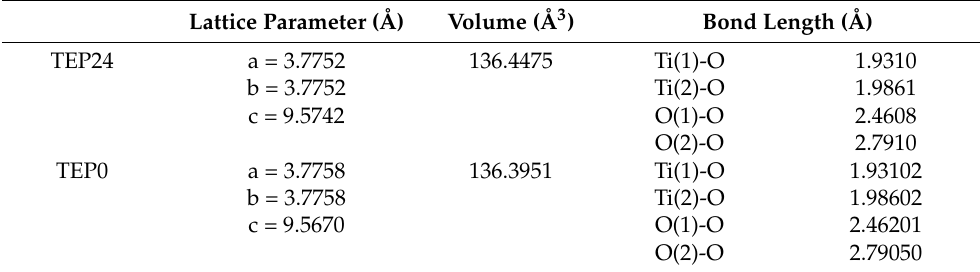
Figure 4. Structure of TiO 2 . The grey and red balls indicate Ti and O atoms, respectively. Table 2. Lattice parameter, volume, and bond length of TEP24 and